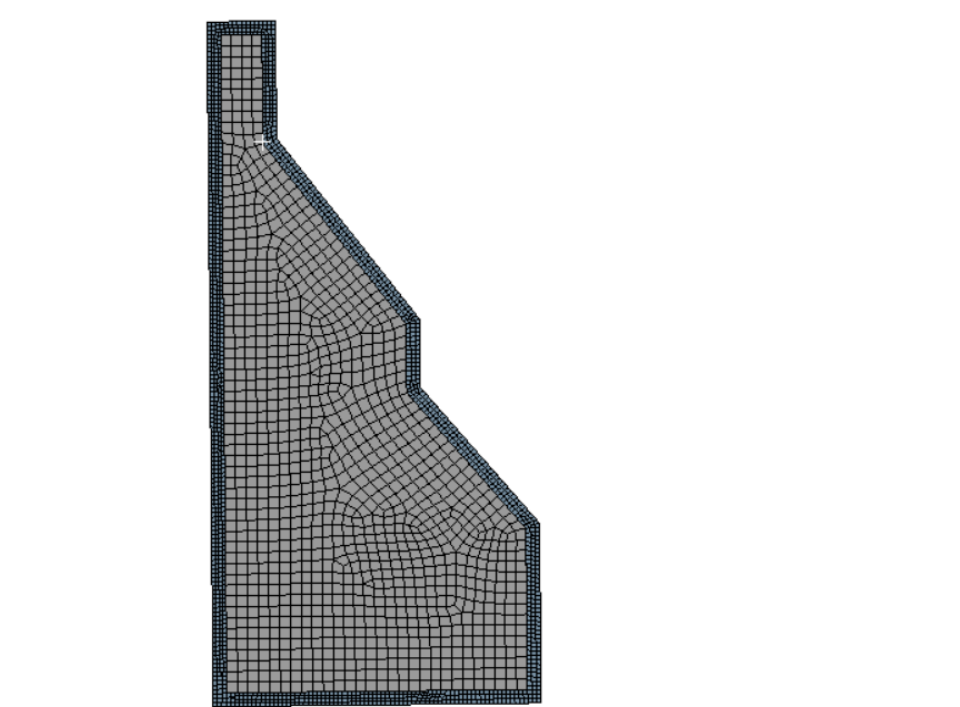
Figure 6. Meshed 2D axisymmetric section, capsule and compact.